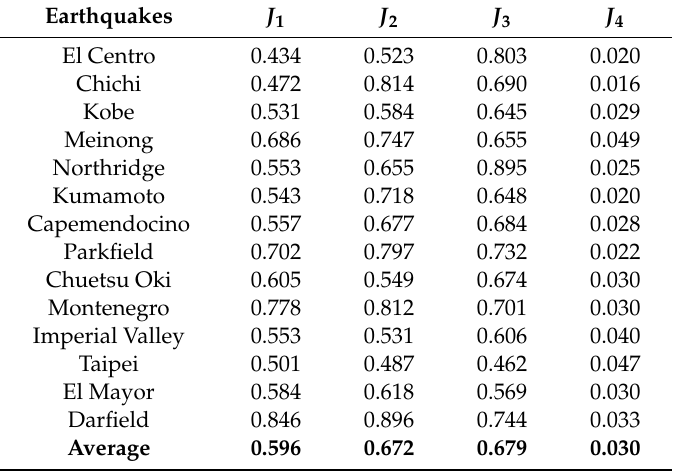
Table 3. SeismiccontrolperformanceoftheLQR(linear-quadraticregulator)-SOS(symbioticorganismssearch).